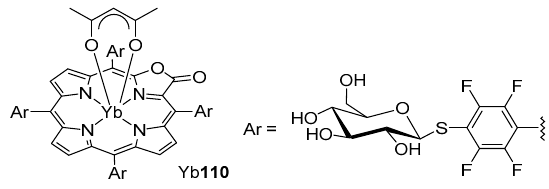
Figure 4. Water-soluble NIR luminescent Yb(porpholactone) complex [116].